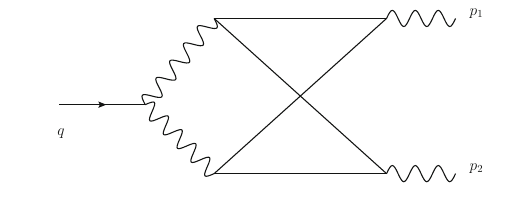
Fig. 6 A non-planar two loop